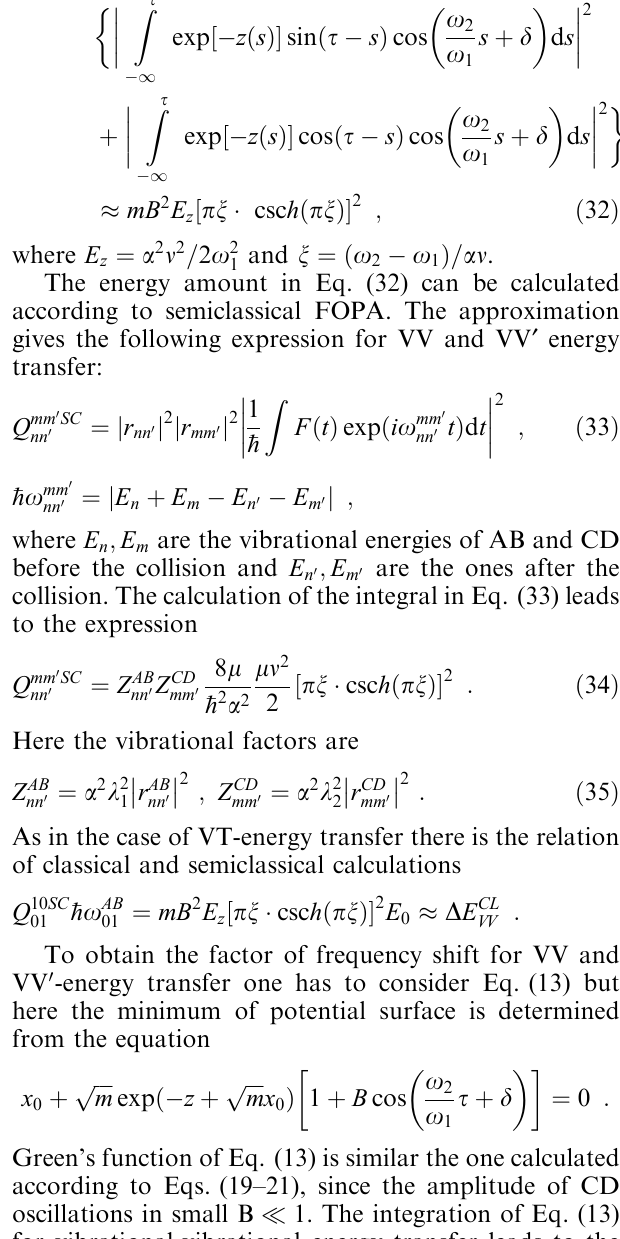
The integration of Eq. (34) over the Maxwell distri-